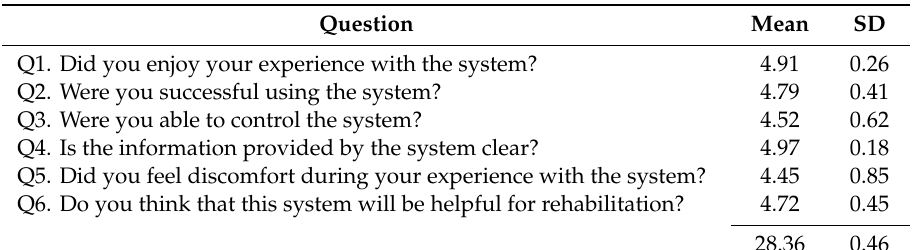
Table 5. USEQ test results for the maze